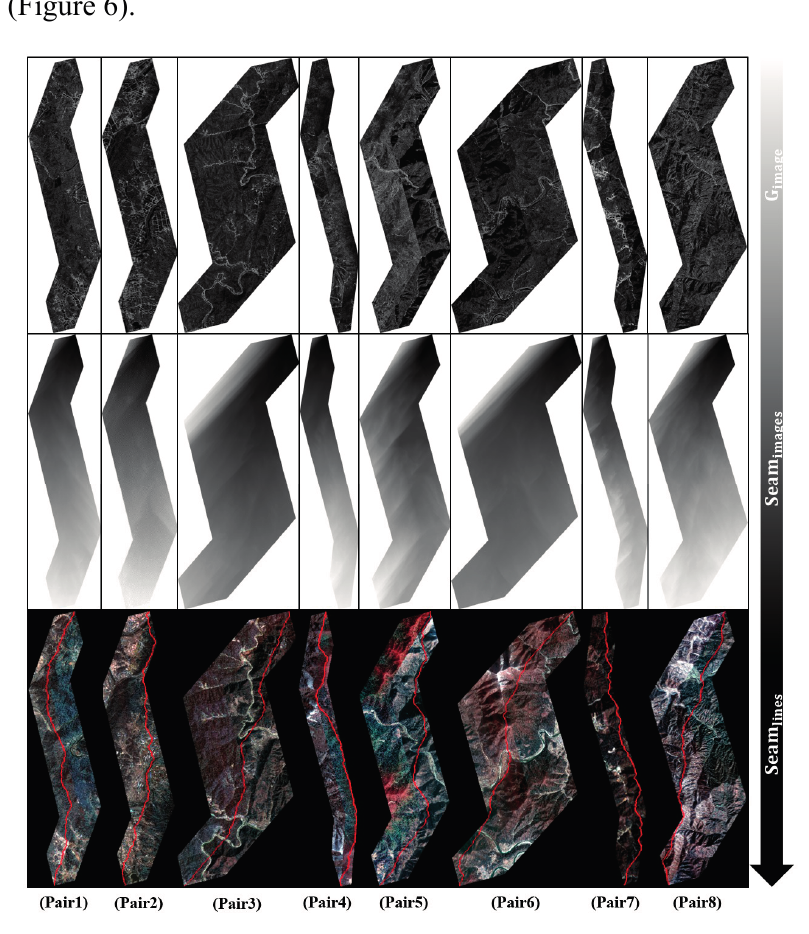
Figure 6. The results of each procedure, i.e. , the gradient magnitude image, seam image and seamline. A gradient magnitude image was computed by convoluting each band (e.g., R, G, and B) and the Sobel operators. A seam image was extracted using a computed gradient magnitude image, and a total of eight seamlines were calculated along the minimum values. For color matching of the mosaic image,